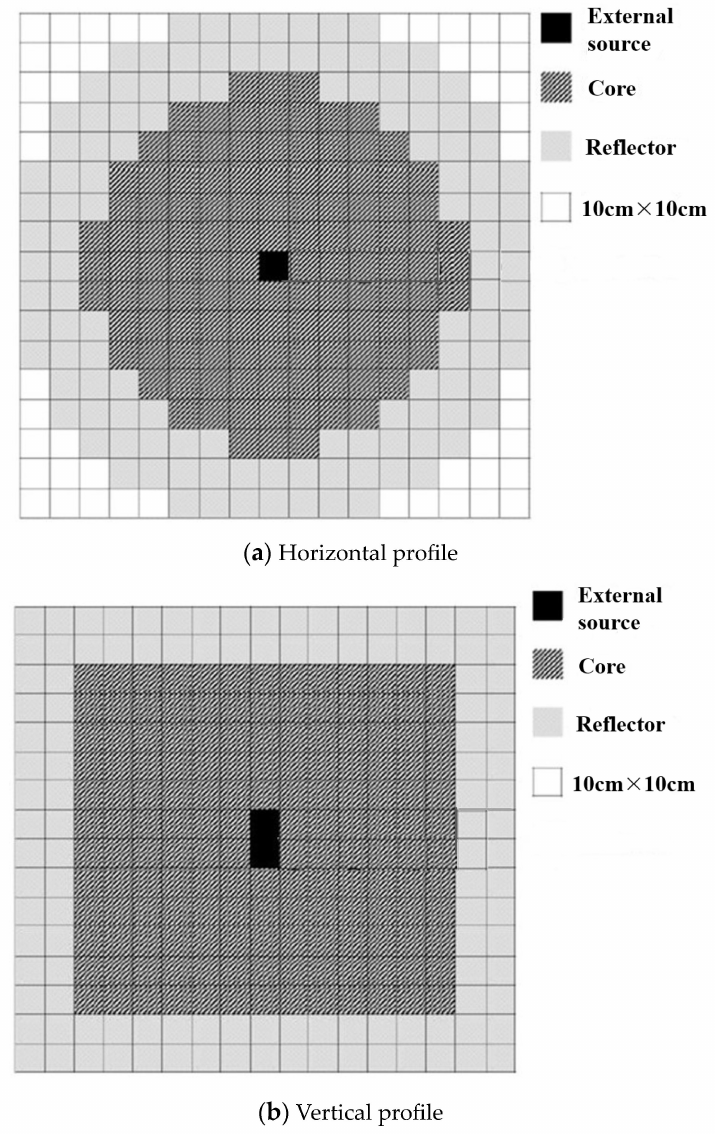
Figure 1. ADSR schematic